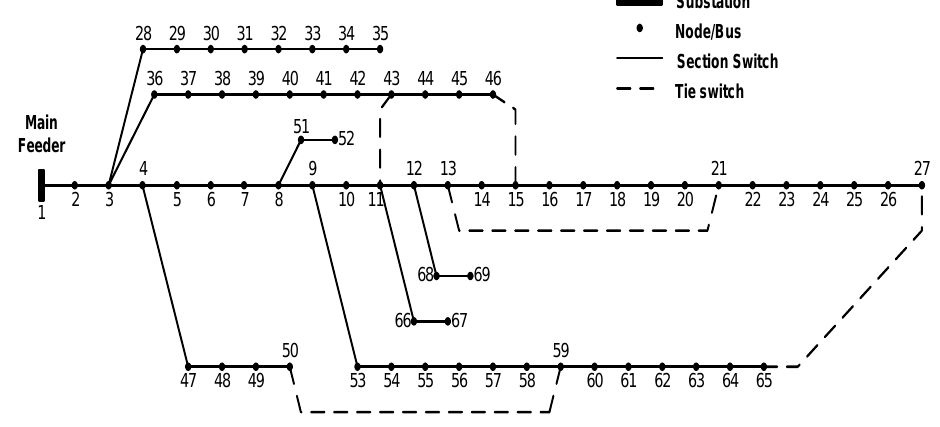
Figure 6. The 69-bus distribution system.